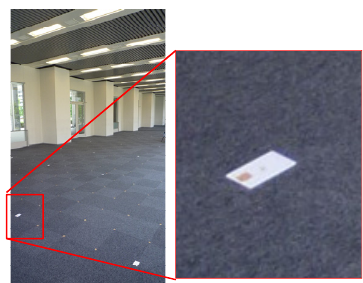
Figure 8. RFID tags installed on the floor